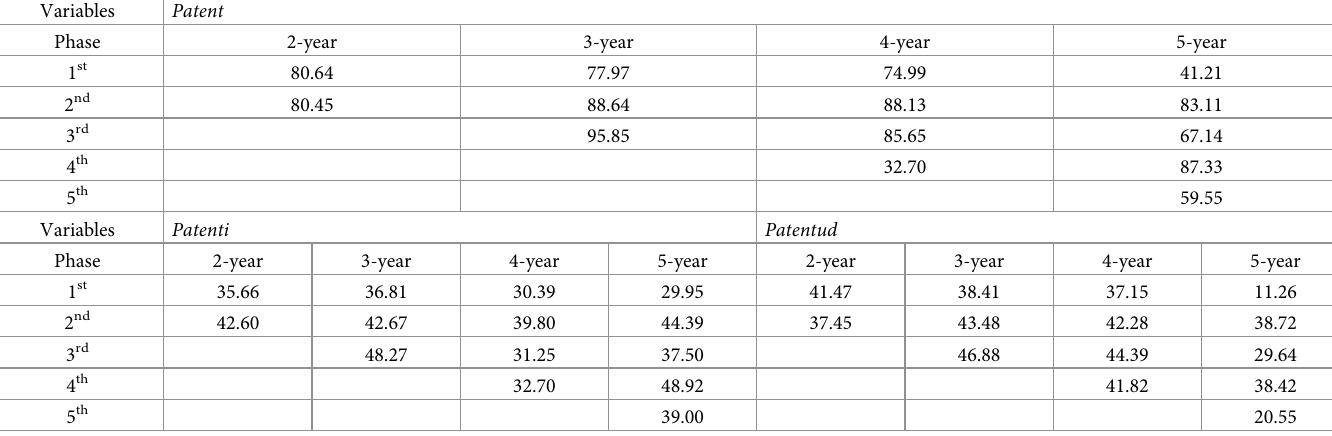
Table 8. Summary statistics of innovation